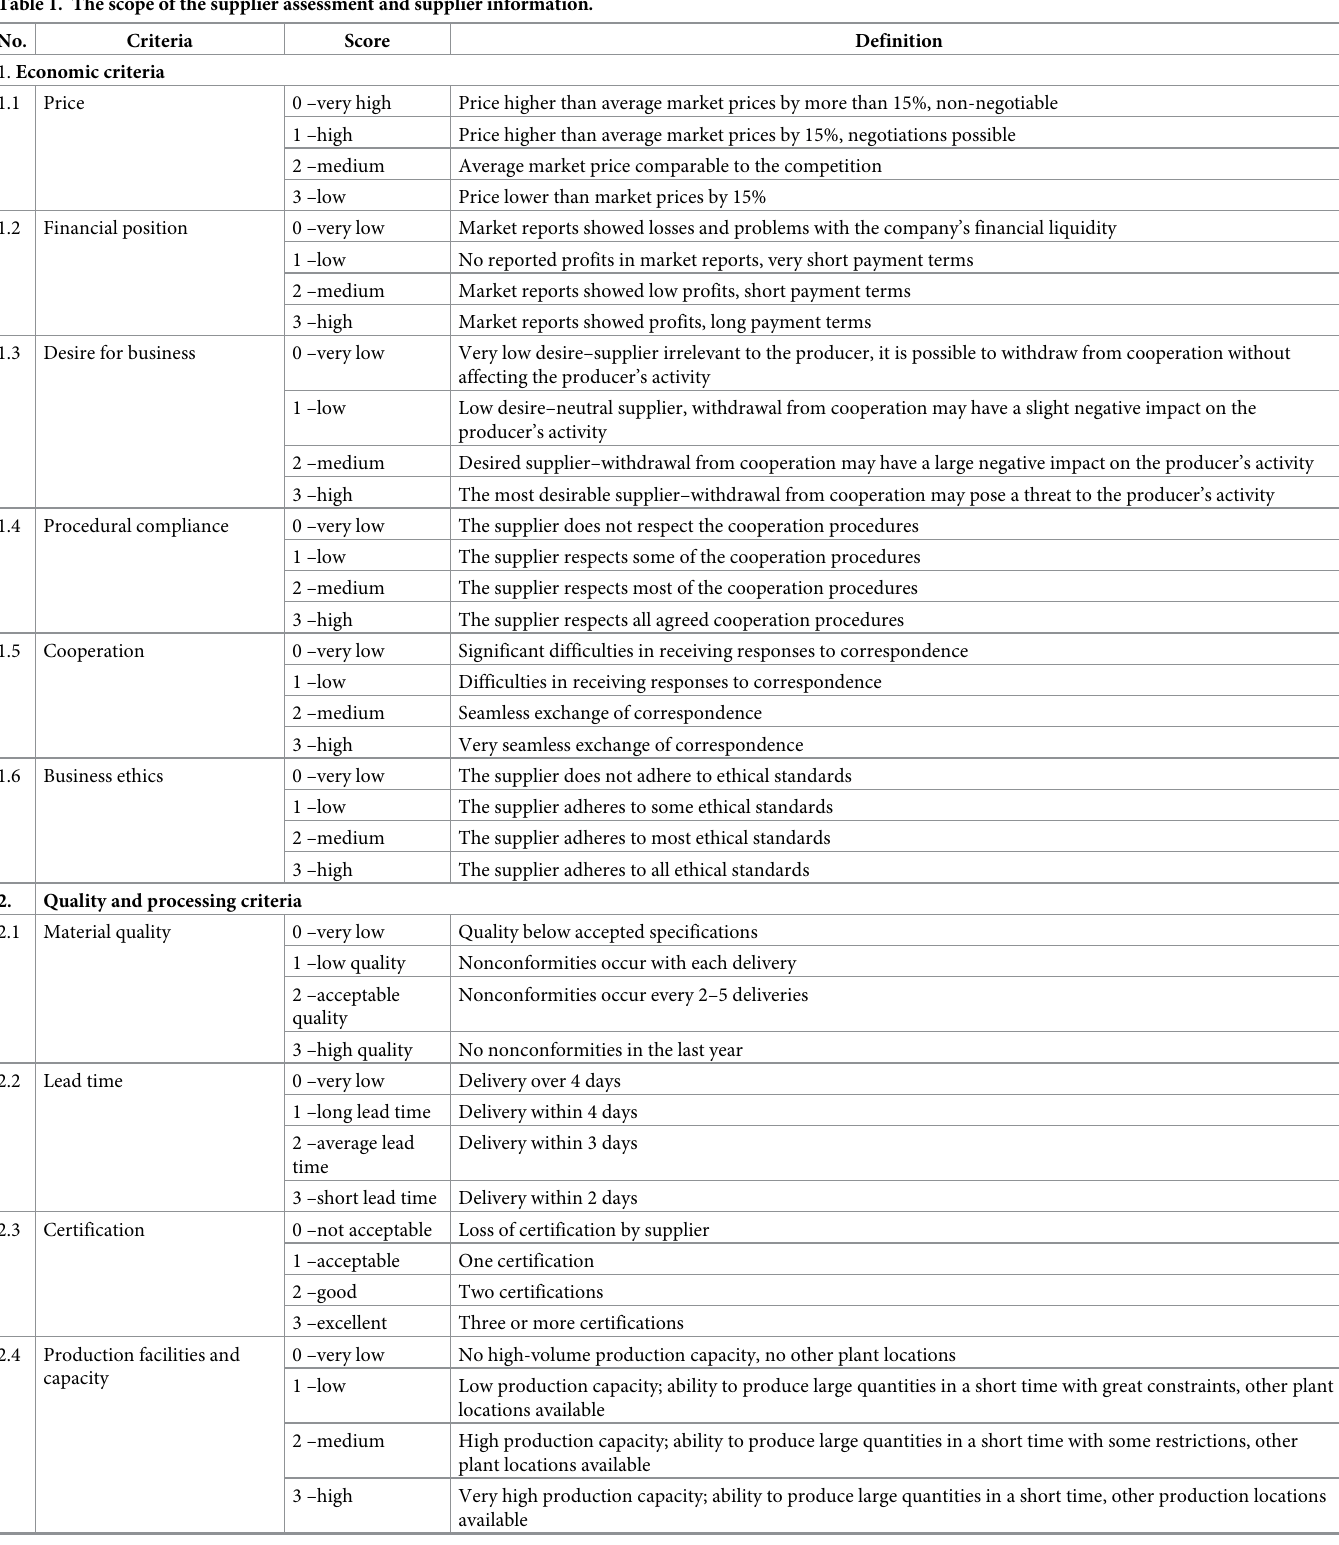
Table 1. The scope of the supplier assessment and supplier information. No.